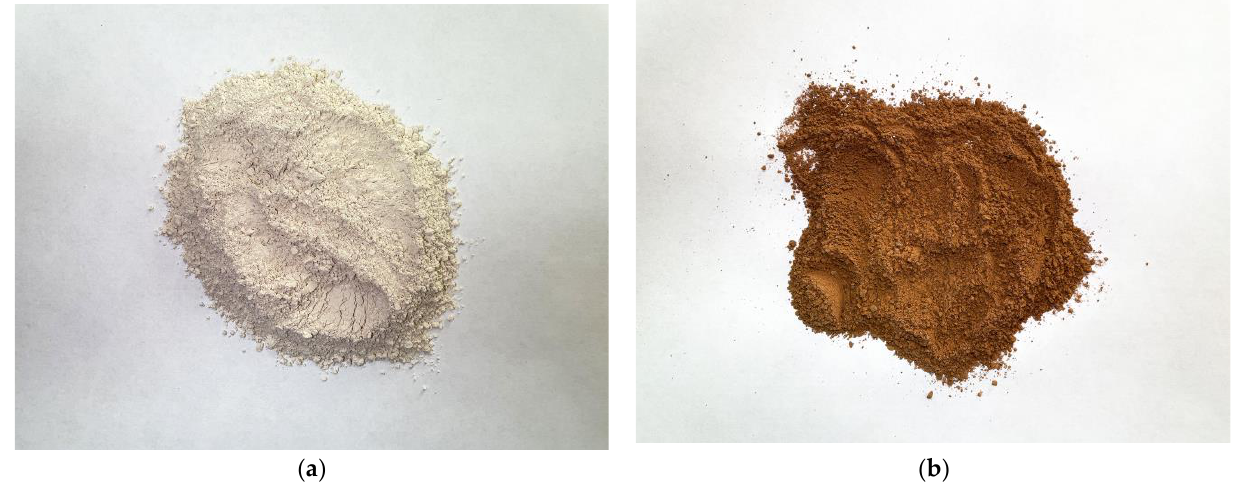
Figure 2. Photo of binder components: ( a ) metakaolin; ( b ) PCW. Table 5. Proportions of geopolymer mixtures based on